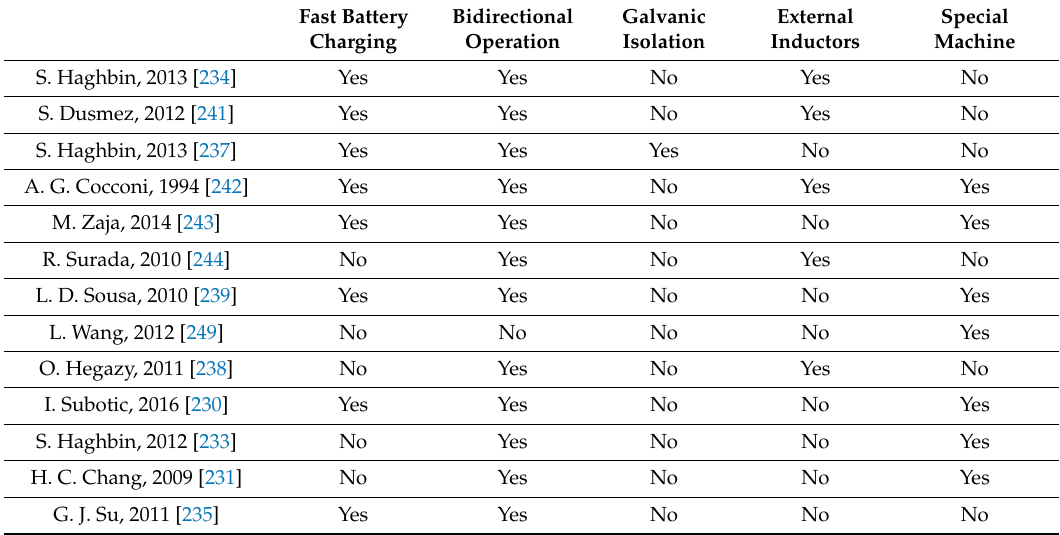
Table 4. Comparison of unified systems for traction and battery-charging